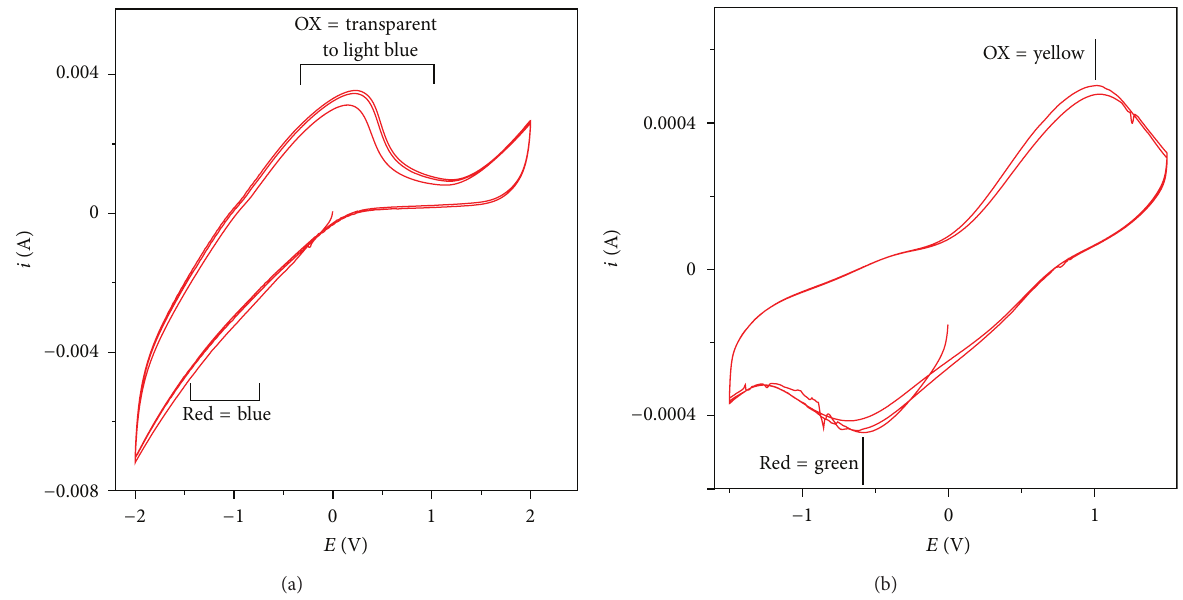
Figure 1: Typical CV of oxide films deposited on ITO prepared in this work. (a) WO 3 /ITO cathode in LiNO 3 0.1M aqueous solution. (b) V 2 O 5 /ITO Anode in LiNO 3 0.1M ethanol solution. Electrodes configuration: ITO/Oxide film as working, Pt as counter, Sat. Ag/AgCl as reference. Scan rate 0.2 V/s. Color change is well visible by naked eye during scansion for both WO 3 and V 2 O 5 . In the plots RED stands for reduced form and OX for oxidized form.